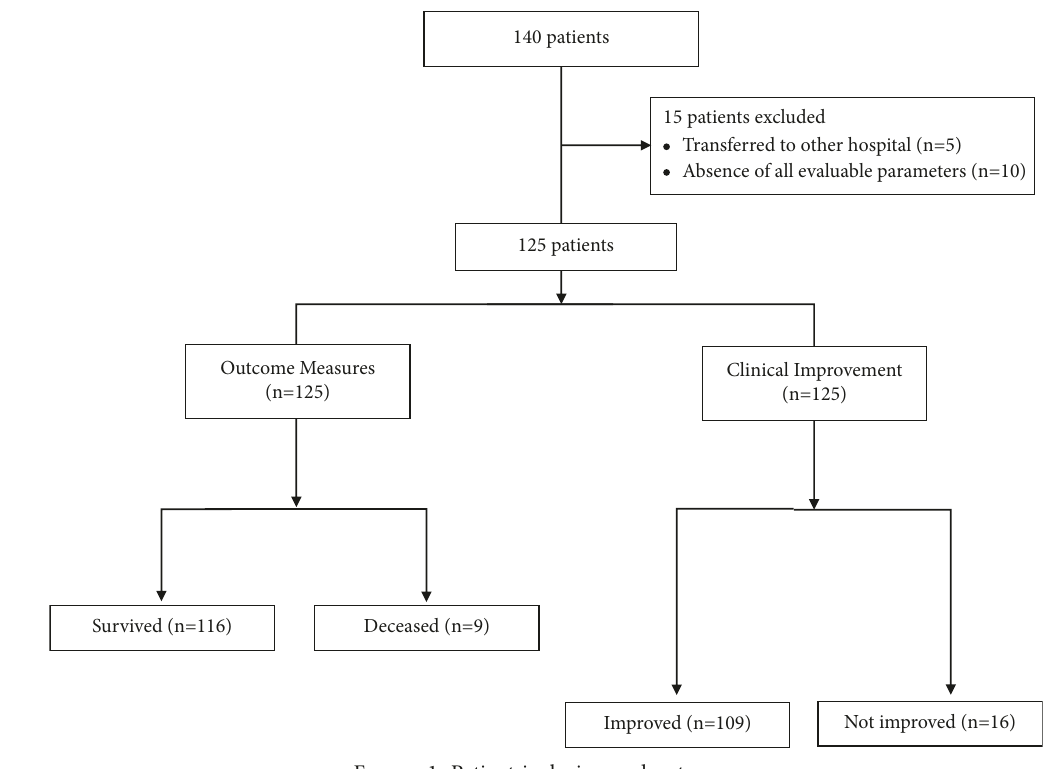
Figure 1: Patient inclusion and outcome. Table 1: Baseline univariate risk factors of survival and improvement in TCZ